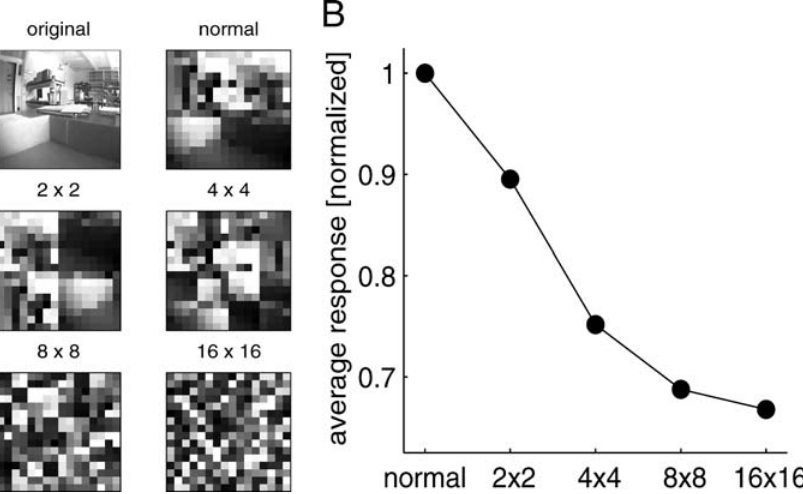
Figure 8. Input Scrambling (A) The original image shows the environment as it is perceived by the camera mounted on top of the robot. The normal image is the downscaled 16 3 16 pixel version that serves as the input to the proposed network model. The four subsequent images show the same input image scrambled by increasing degrees, i.e., by randomly permuting 2 3 2, 4 3 4, 8 3 8, or 16 3 16 blocks of equal size. (B) Average response of the units at the third level of the hierarchy for a normal visual input as well as the four different scales of spatial scrambling. DOI: 10.1371/journal.pbio.0040120.g008